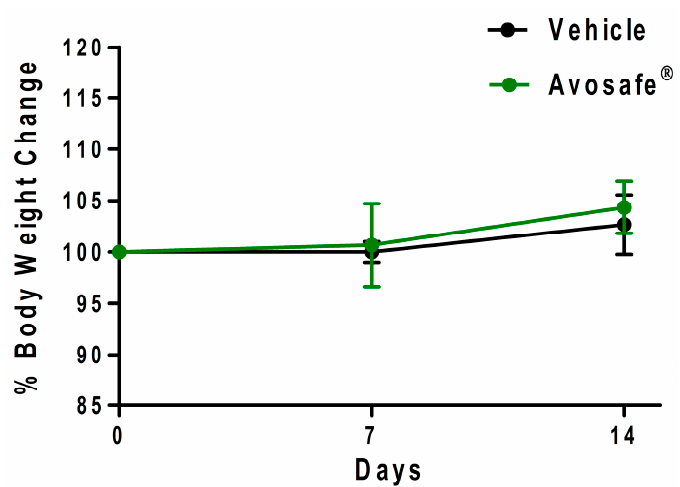
Figure 6. Body weight (bw) change in rats over time (14 days) following acute oral administration (2000 mg · kg − 1 ) of a food-grade extract from avocado seed (Avosafe ® ), with an acetogenin purity of 94.74%. Values represent mean ± SD ( n = 3).